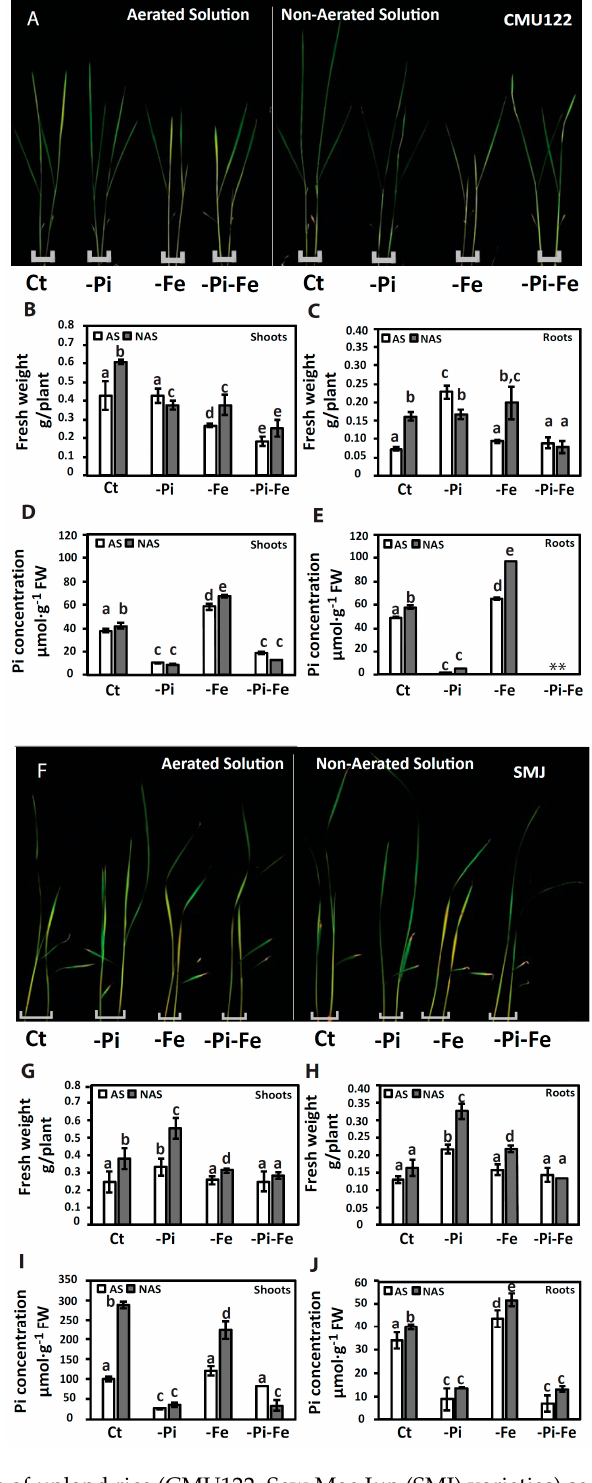
Figure 2. Responses of upland rice (CMU122, Sew Mae Jun (SMJ) varieties) seedlings grown under various O 2 and nutrient deficiency conditions. Ten-day-old seedlings were transferred to one of the combinatory treatments consisting of O 2 (aerated solution (AS) and non-aerated solution (NAS)) nutrient treatments (full strength nutrient solution (Ct), phosphate deficiency ( − Pi), iron deficiency ( − Fe) and Pi and Fe deficiency ( − Pi-Fe)). ( A , F ) Phenotypes of seedlings after 10 days of treatment; ( B , G ) shoots and ( C , H ) roots biomass of seedlings after 10 days of treatment; ( D , I ) shoots and ( E , J ) roots Pi concentration of seedlings after 10 days of treatment. The data are given as mean ± s.e. ( n = 3). Letters a, b, c, d, e on histograms indicate statistical significance at p < 0.05. FW, fresh weight.